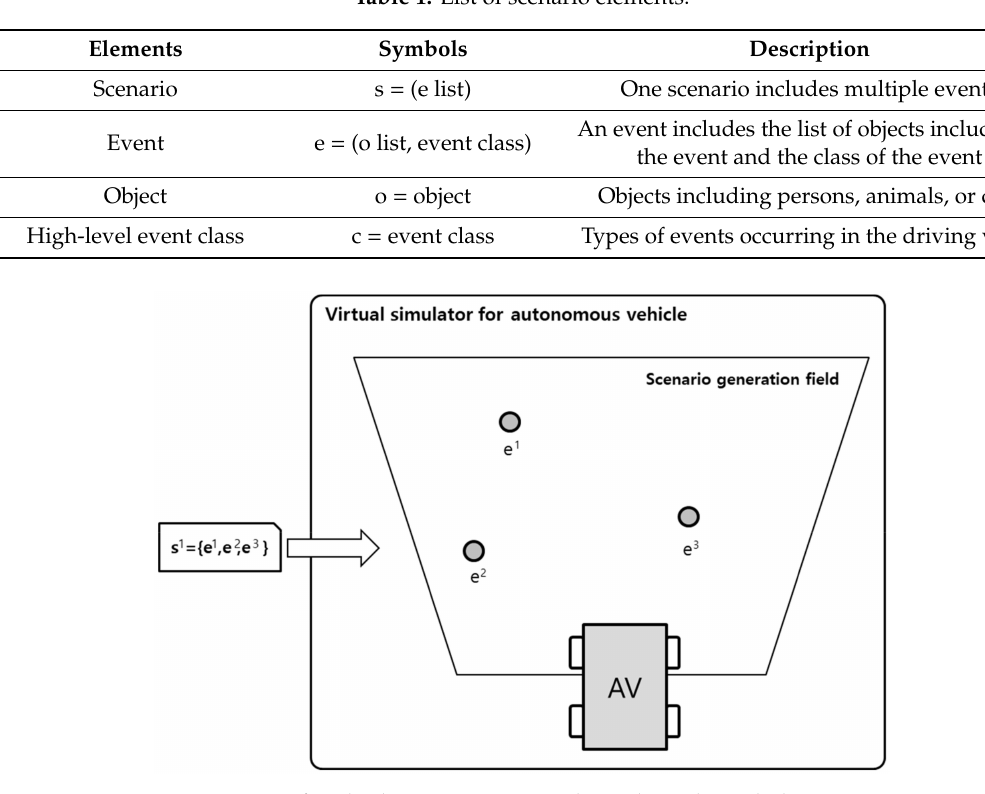
Figure 5. Execution of multiple events in a virtual simulator through the scenario